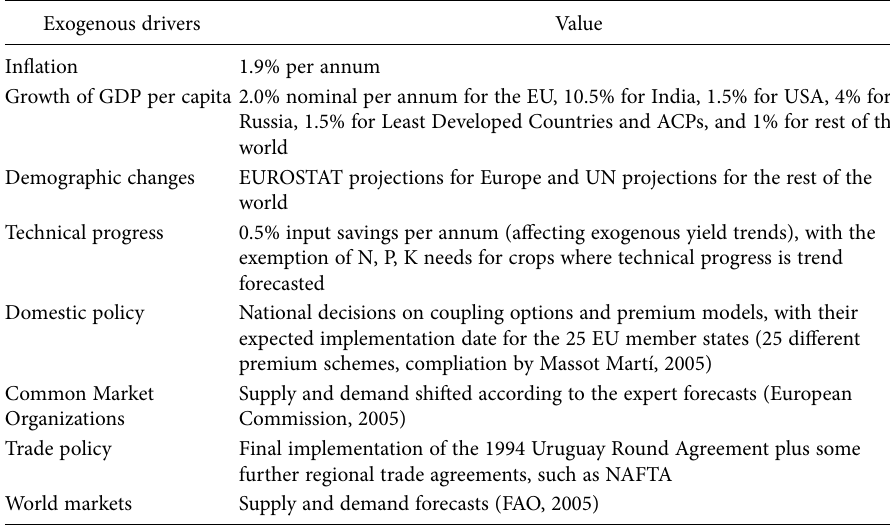
Table 1. Exogenous drivers considered for the baseline